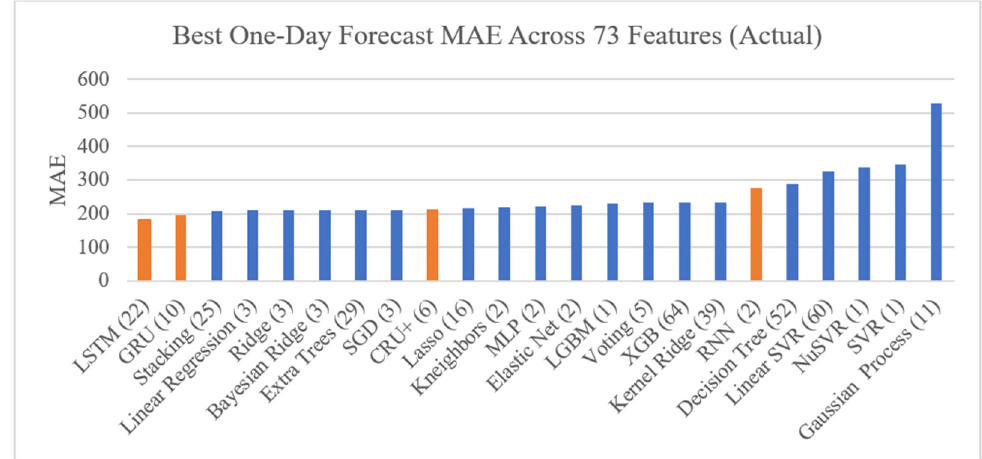
Figure 13. Best One-Day Forecast MAE Found Across 73 Features (Actual). Recurrent (orange) and non-recurrent (blue) models are trained with an iteratively increasing number of ranked features, seen in Supplementary Materials Figure S10, for one-day forecasting. The lowest MAE for each model is recorded with the number of features next to the model’s name.